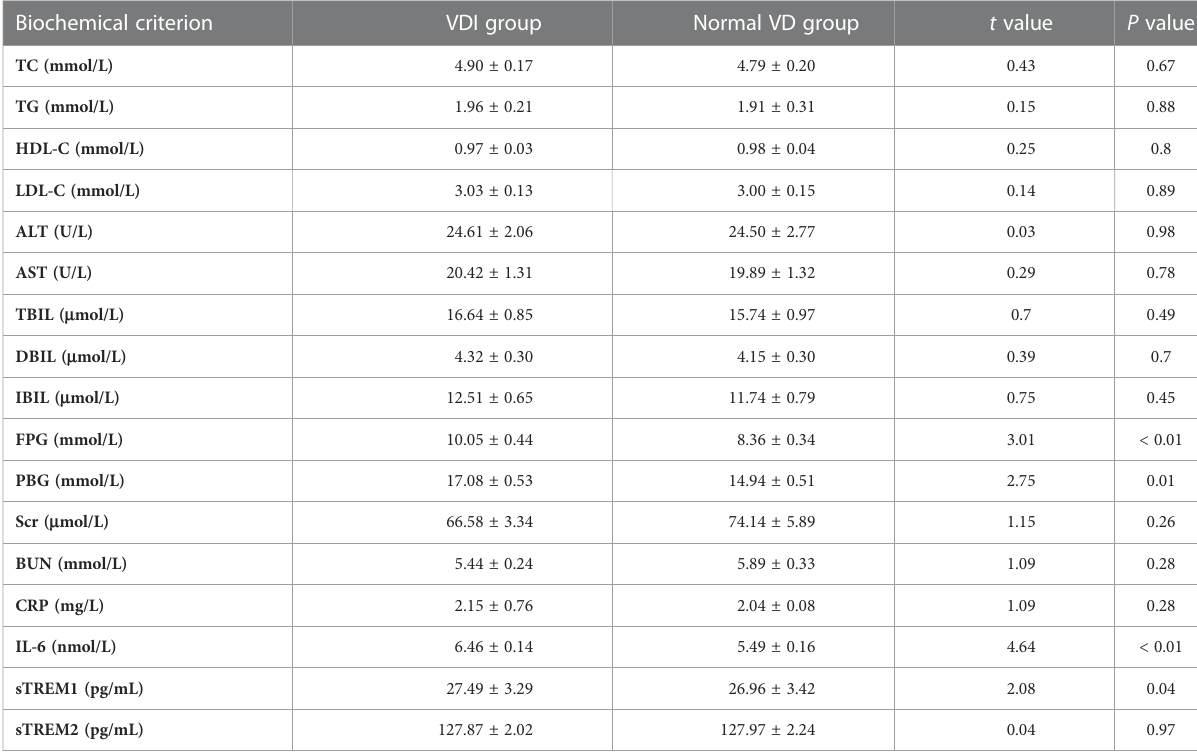
TABLE 2 The biochemical indicators of glycolipid metabolism and in fl ammatory cytokines in T2DM patients with different plasma 25(OH)D levels. Biochemical